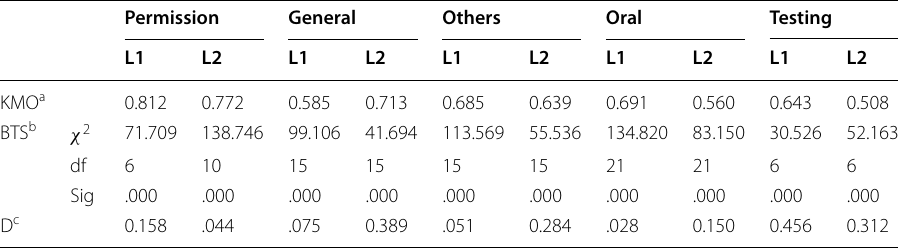
Note: a Kaiser-Meyer-Olkin measure of sampling adequacy